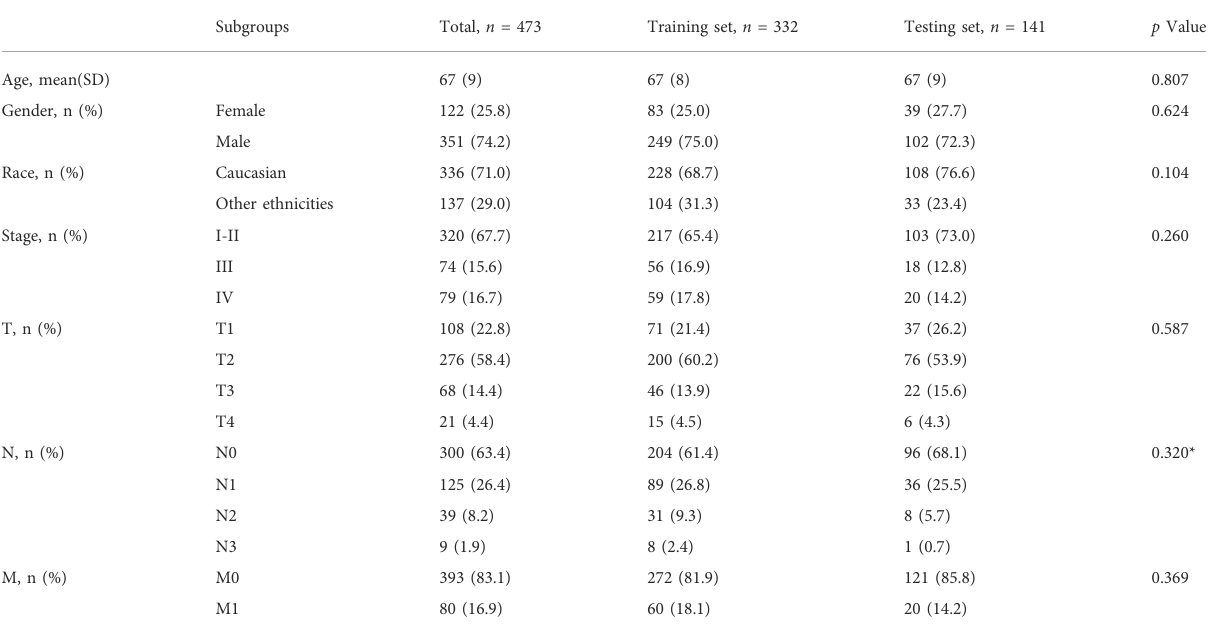
TABLE 1 The baseline characteristics of LUSC patients in TCGA